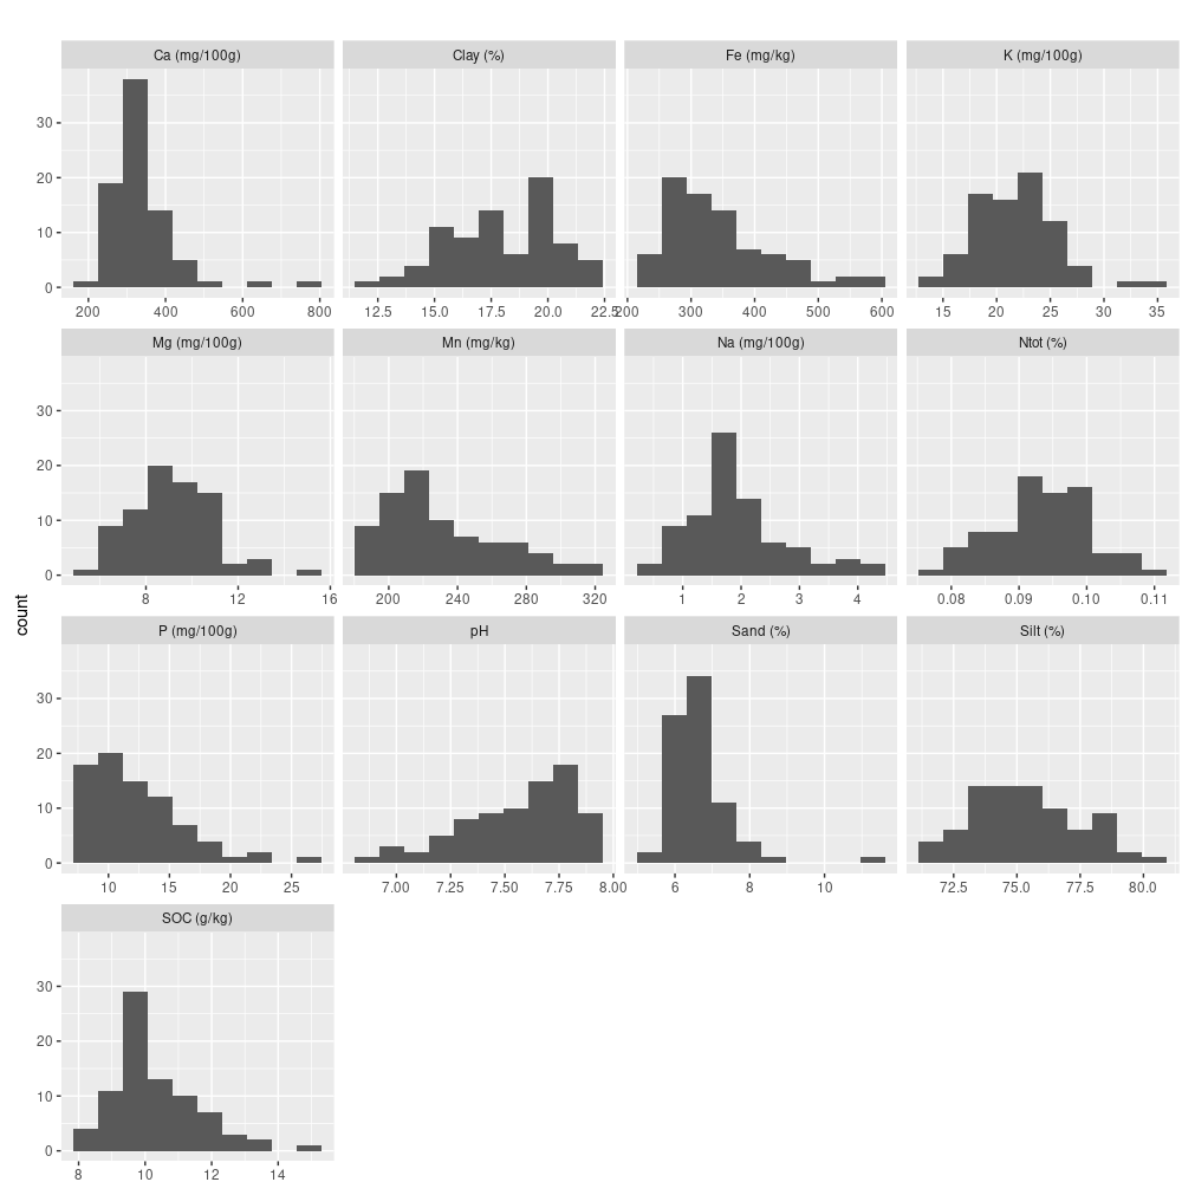
Figure A1. Distribution frequency of the physical and chemical soil parameters (80 soil samples) over the whole studied field in 2018.